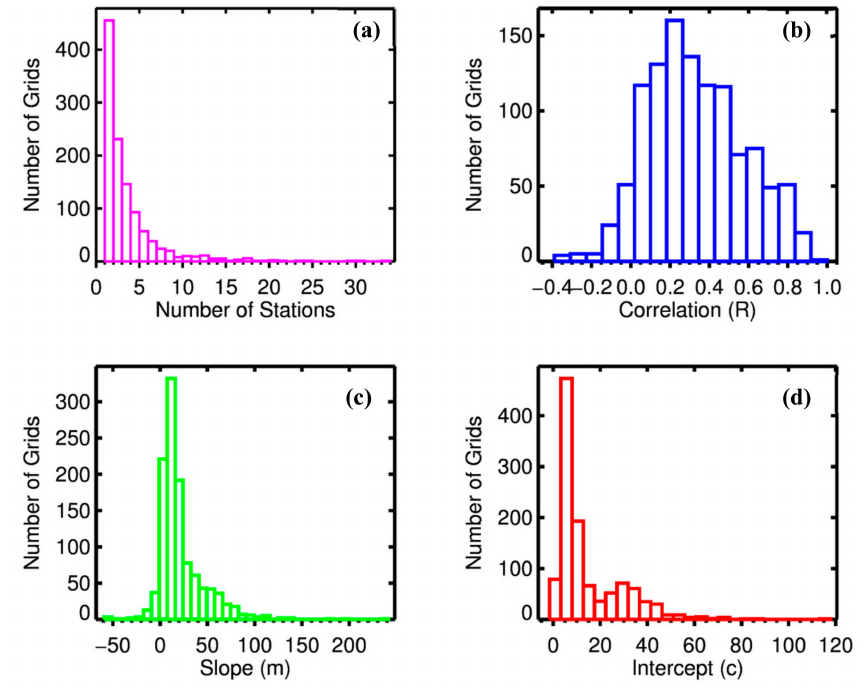
Figure 4. The frequency distribution of the AOD–PM 2.5 relationships. in 1 × 1 degree grids for ( a ) number of surface monitors / stations, ( b ) linear correlation coefficient (R), ( c ) slope (m), ( d ) and intercept ( c